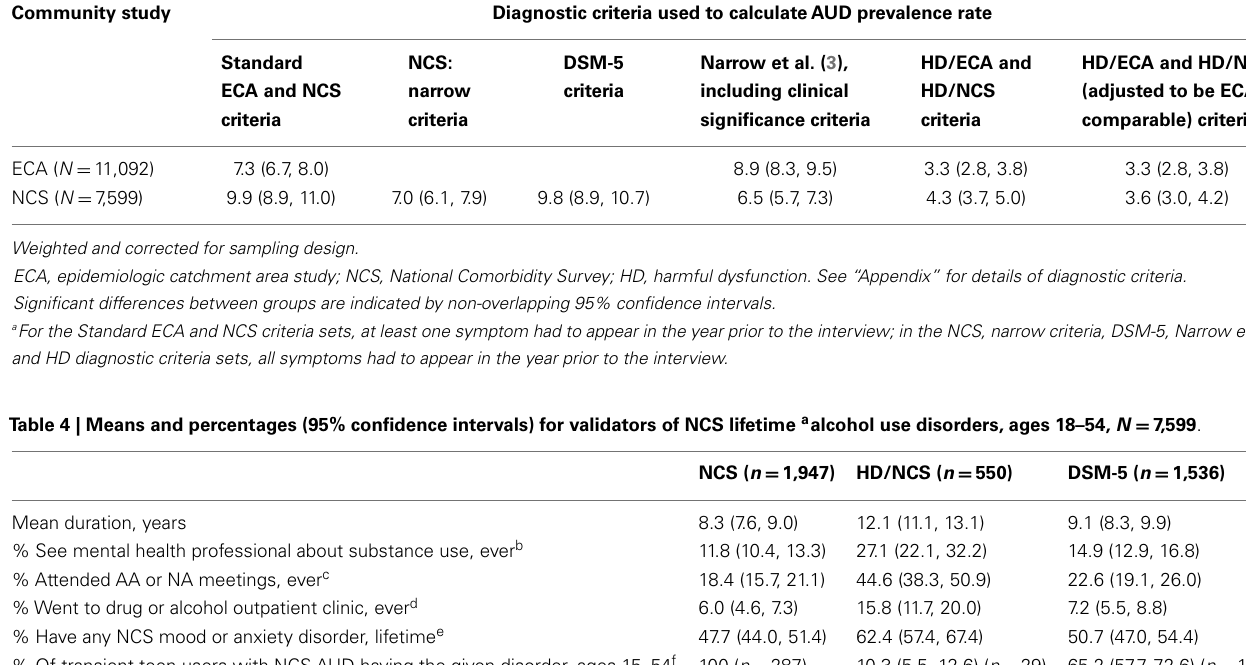
Table 3 | One-year a prevalence (95% confidence intervals) for alcohol use disorder (AUD) in the ECA and NCS community studies, using standard versus harmful dysfunction (HD) diagnostic criteria, and limited to common age range of 18–54 . Community